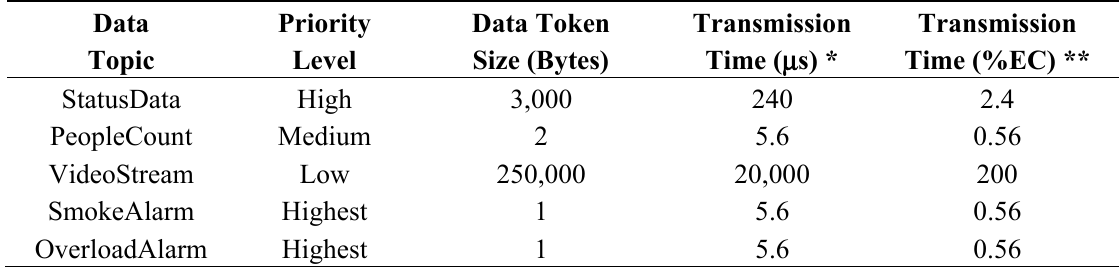
Table 4. Size and priority values associated to each data